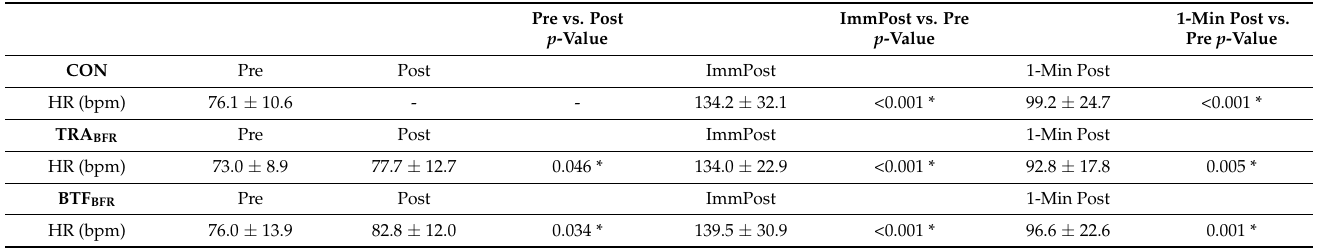
Table 3. Changes in heart rate following occlusion and exercise (M ± SD).